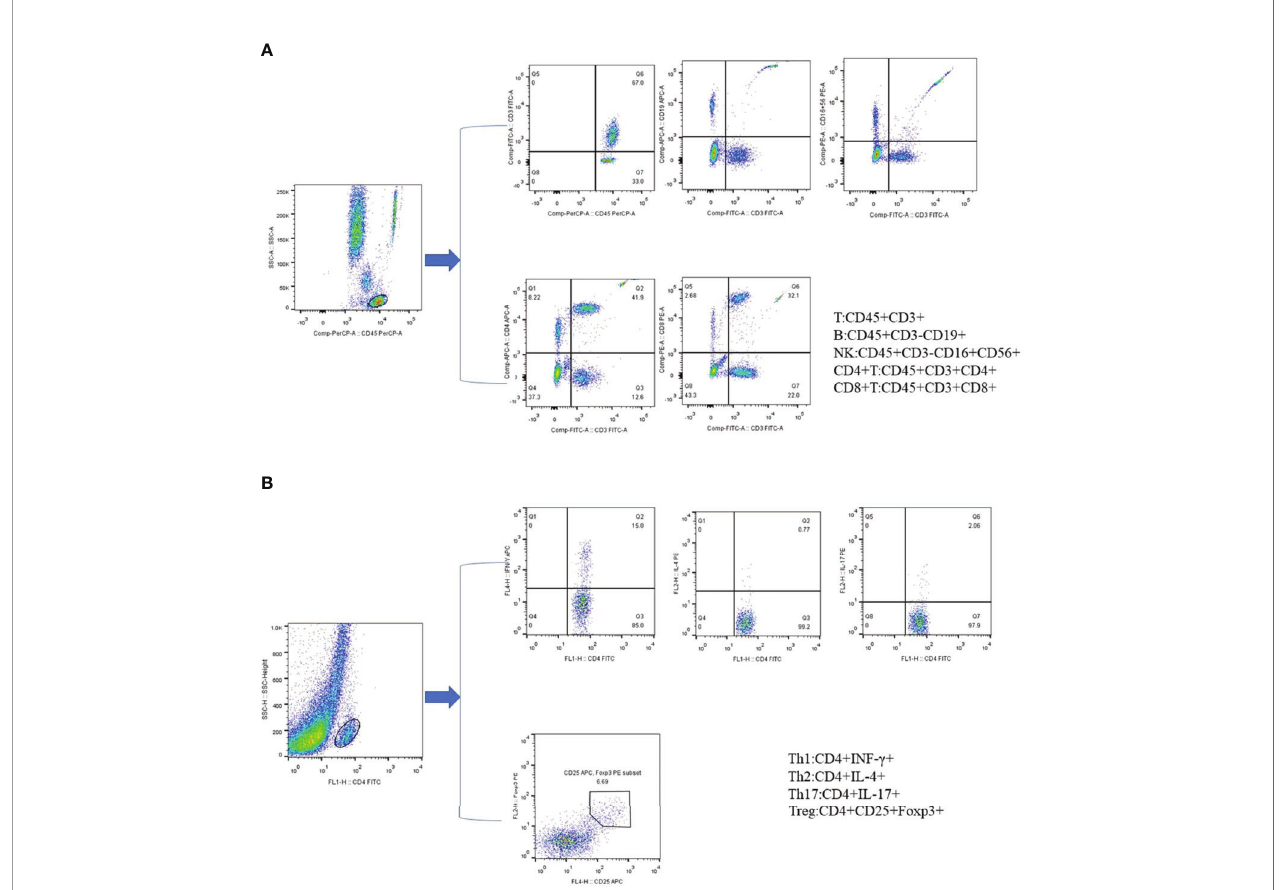
FIGURE 1 | Phenotypic characterization of lymphocyte subpopulations by fl ow cytometry. (A) Representative fl ow cytometry analysis of peripheral lymphocytes. (B) Representative fl ow cytometry analysis of CD4+ T cell subsets. All dot plot analysis is of CD4+ gated